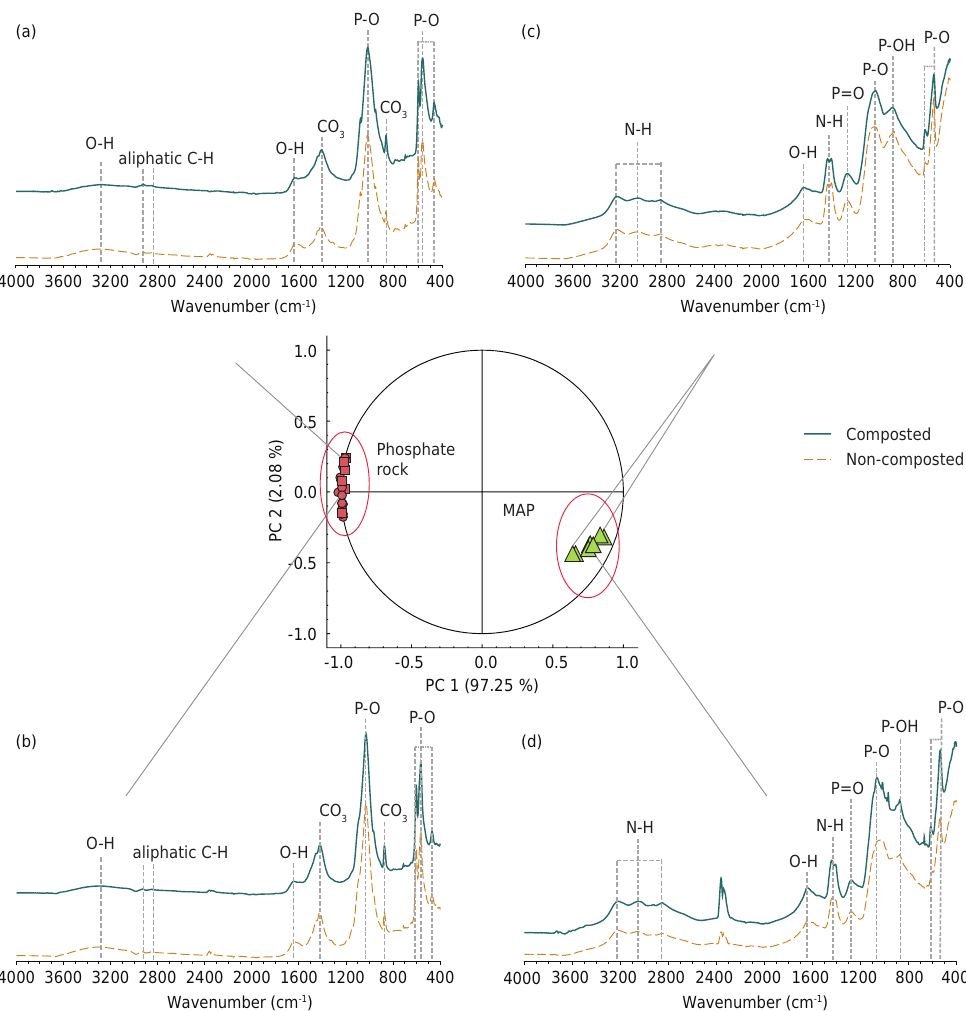
Figure 5. Principal component analysis (PCA) of absorption bands and mean spectra of ATR-FTIR and main chemical groups recorded for the mixtures with Araxá phosphate rock (a), Bayóvar phosphate rock (b), 25 and 75 % of MAP (c), and 40 and 50 % of MAP (d) composted (150 days of incubation) and non-composted (without